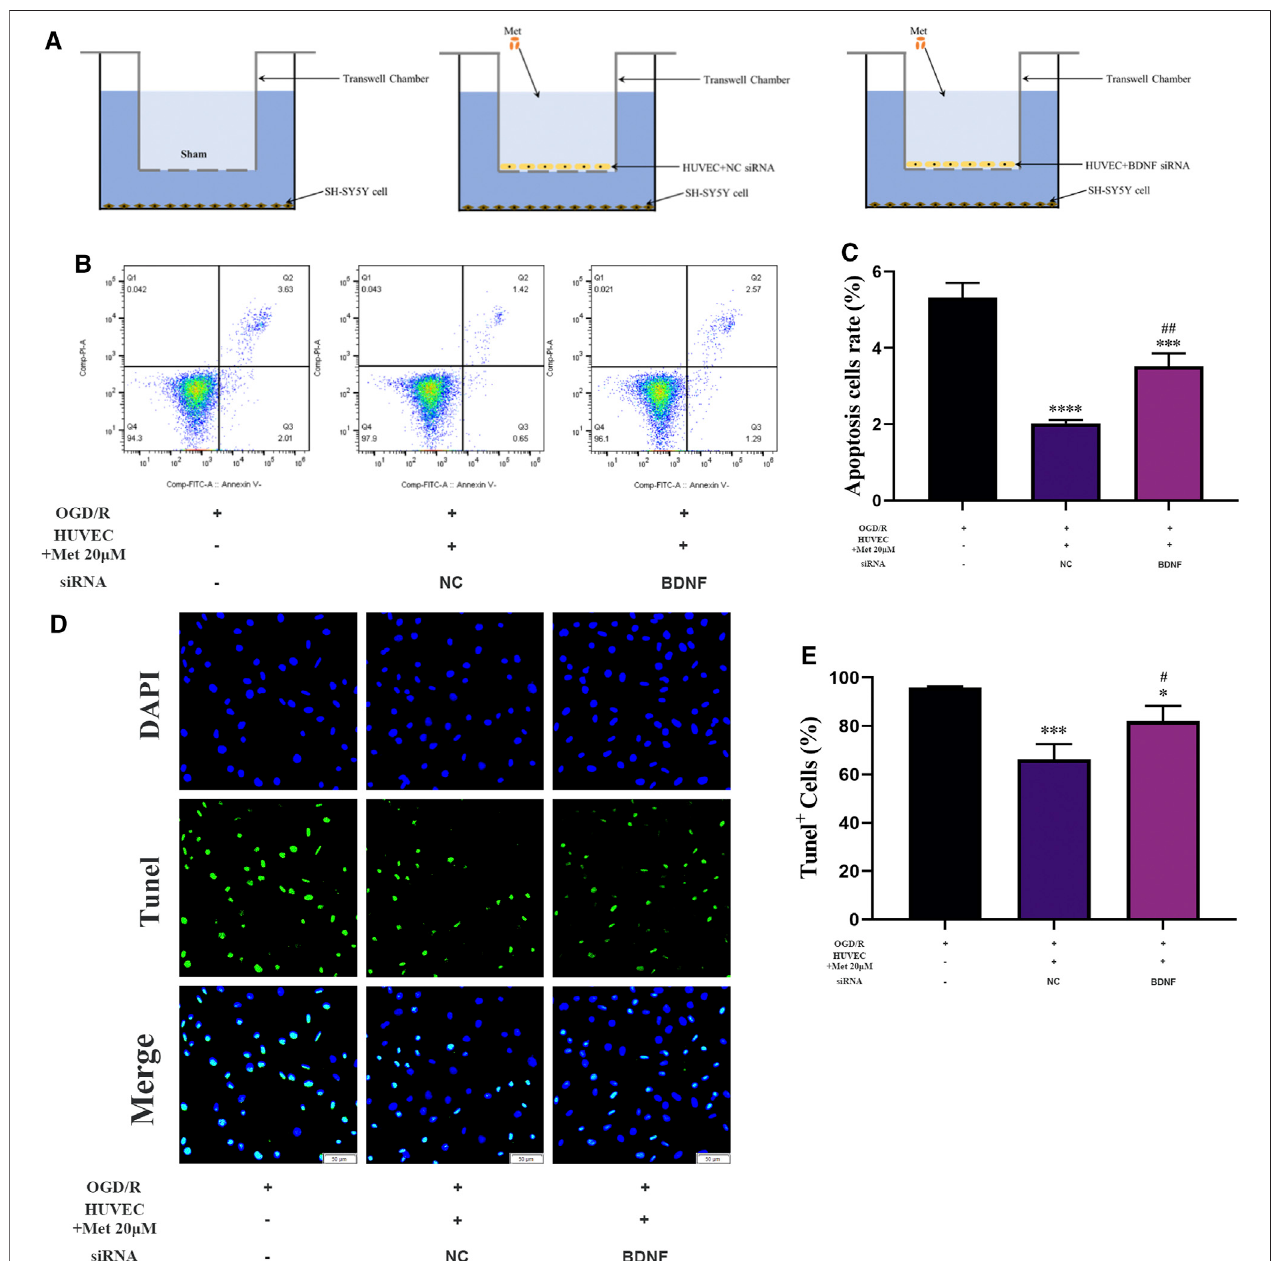
FIGURE 8 | HUVECs treated with metformin reduce apoptosis of SH-SY5Y cells under OGD/R conditions. (A) Schematic diagram of grouping in the Transwell chamber assay. (B – E) Apoptosis of SH-SY5Y cells was detected by TUNEL staining ( n = 3, bar = 50 μ m) and fl ow cytometry ( n = 3). (* p < 0.05, *** p < 0.001, **** p < 0.0001 vs. OGD/R; # p < 0.05, ## p < 0.01 vs. OGD/R + HUVEC + Met 20 μ M + NC siRNA; NC, negative